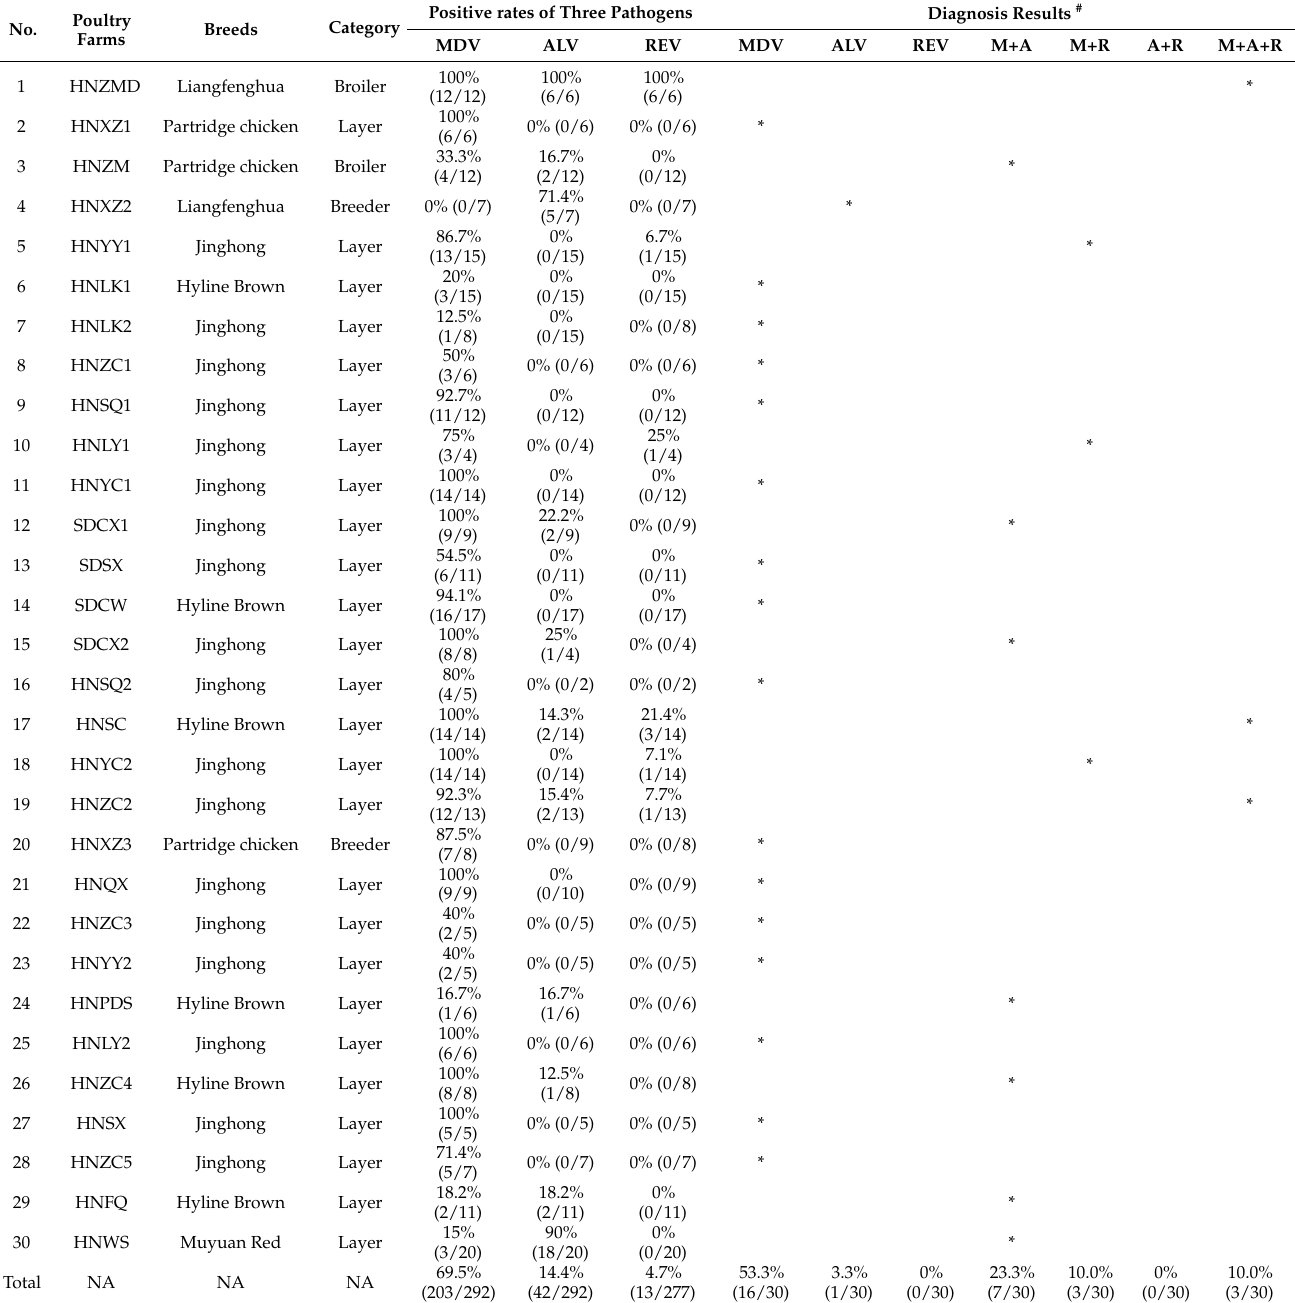
Table 3. Co-infections of three pathogens in chickens with suspected neoplastic disease from poultry farms distributed in central